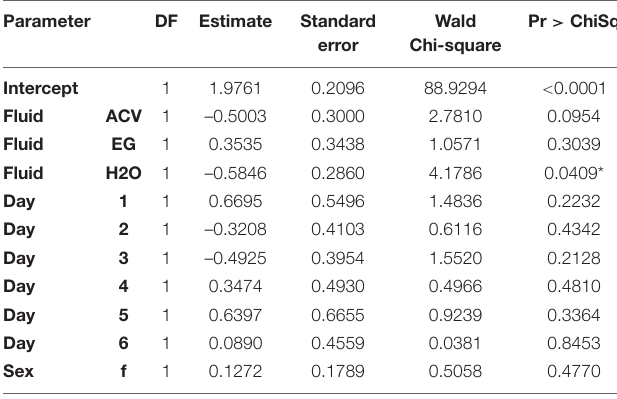
TABLE 8 | Analysis of maximum likelihood estimates of blueberry-fed flies in trap fluid.